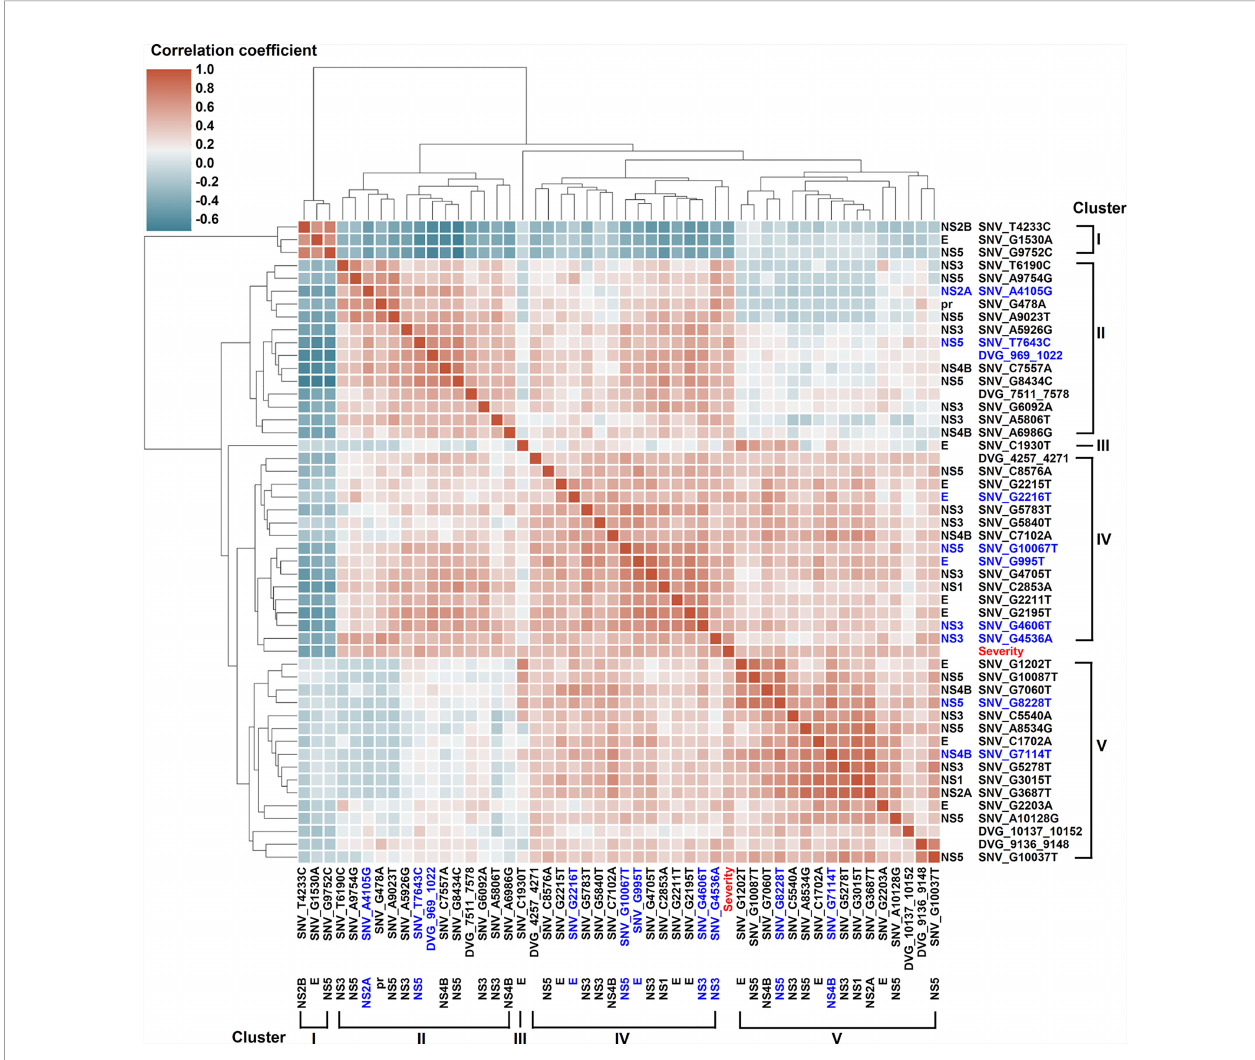
FIGURE 5 | Interactive correlation of SNVs/DVGs highly associated with disease severity in DENV-2-infected patients. The 44 SNVs and the junction regions of 5 DVGs highly associated with disease severity in DENV-2-infected patients with p < 0.001 in Mann – Whitney U test were selected in the plot. The 9 SNVs and the junction regions of 1 DVG with p < 0.0001 in Mann – Whitney U test were highlighted in blue. The correlation coef fi cient of each SNVs/DVGs pair was evaluated by the Spearman ’ s rank correlation method and displayed using hierarchically-clustered heatmap. Heatmap assigns a continuous color for correlation coef fi cients, and hierarchical cluster groups the SNVs/DVGs exhibiting similar pro fi les into clusters.